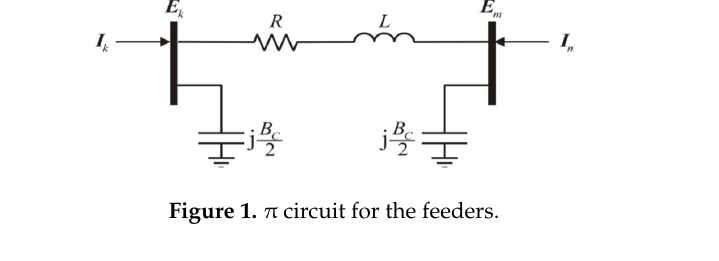
Figure 1. π circuit for the feeders.